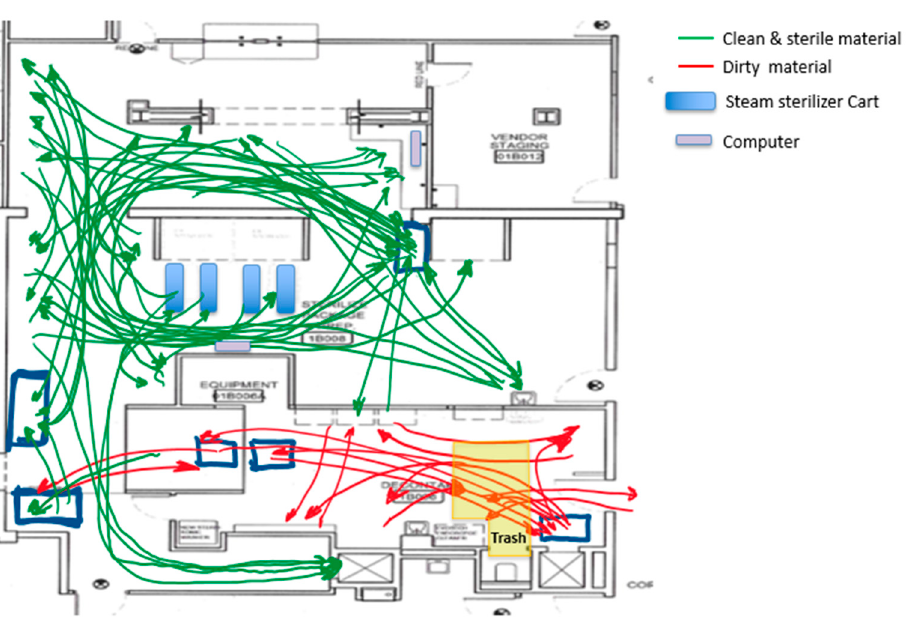
Figure 7. Spaghetti diagram of the current state.